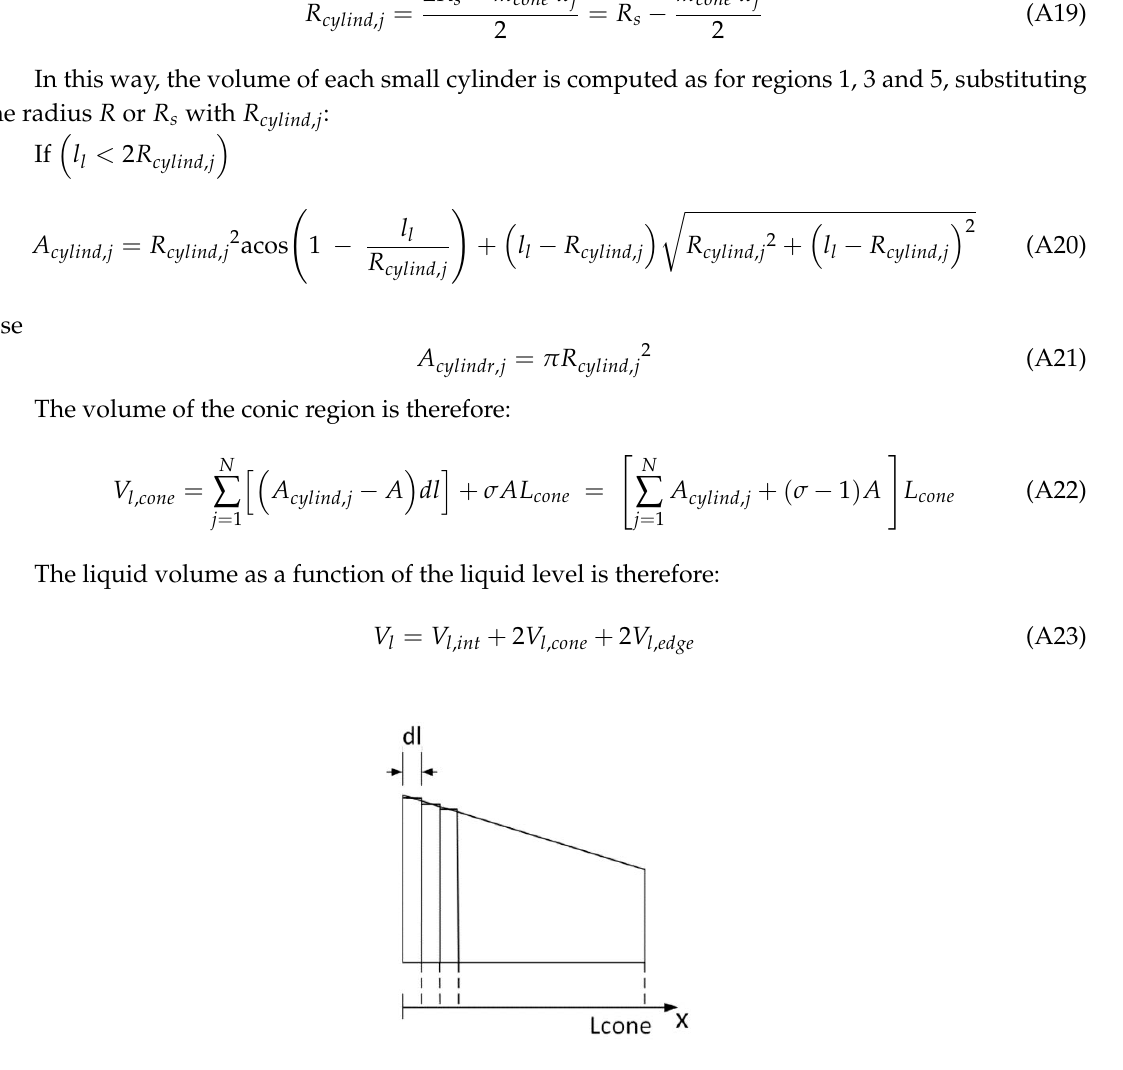
Figure A3. Discretization of the conic region.